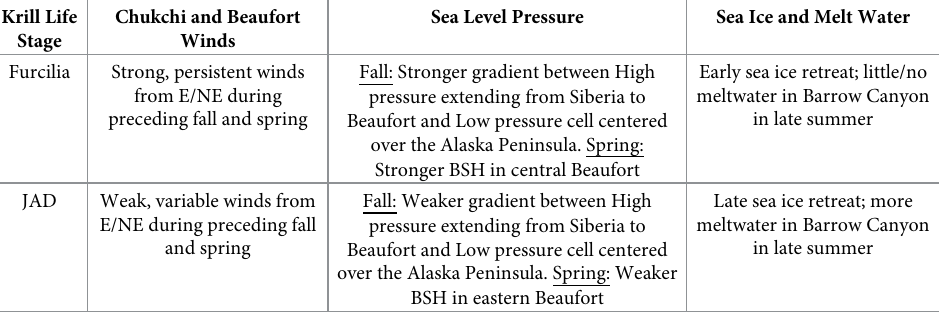
Table 2. Summary of physical characteristics associated with either furcilia or JAD dominance in the krill popula- tion near Pt. Barrow,